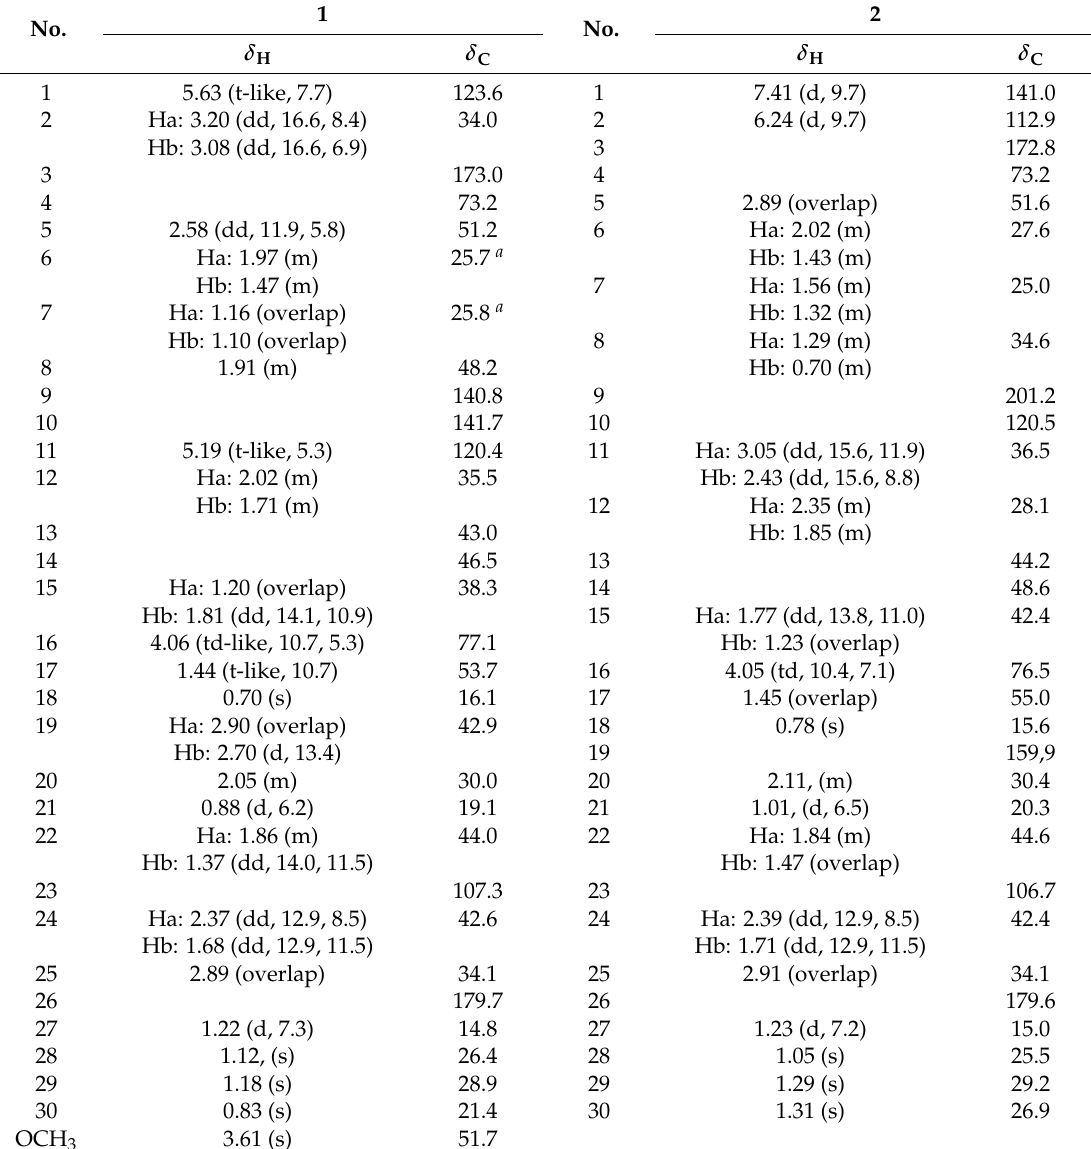
Table 1. 1 H (600 MHz) and 13 C-NMR (150 MHz) data of 1 and 2 in CDCl 3 ( δ in ppm, J in